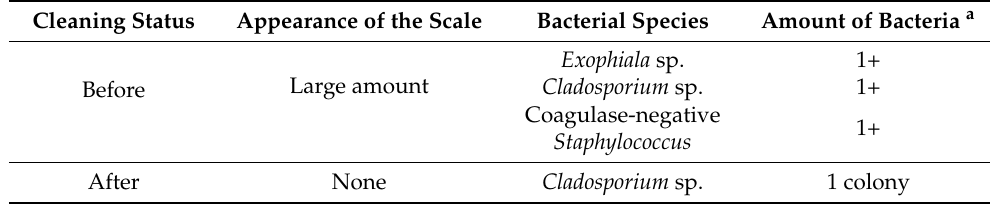
Table 3. Scale and bacteria detection status before and after cleaning around the washbasin tap with Space Shot